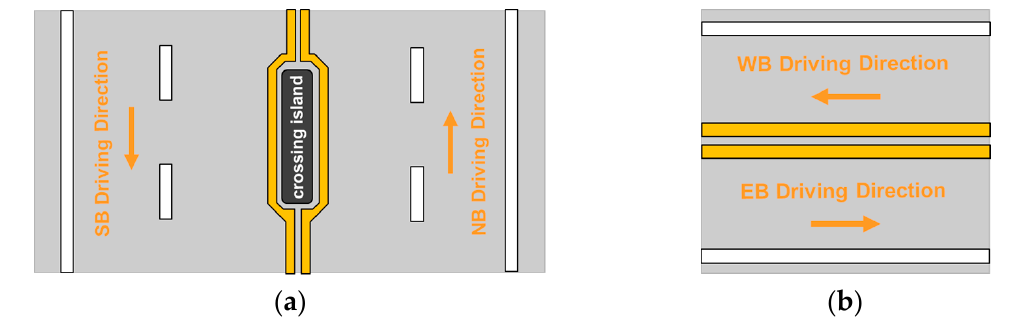
Figure 21. Better performance of fine-tuned models over one trained from scratch on new test dataset: ( a ) RGB image for location i (same location i as in Figure 17); ( b ) corresponding intensity image; ( c ) encoder-trained U-net predictions; ( d ) decoder-trained U-net predictions; ( e ) predictions by the U-net trained from scratch showing false negatives.